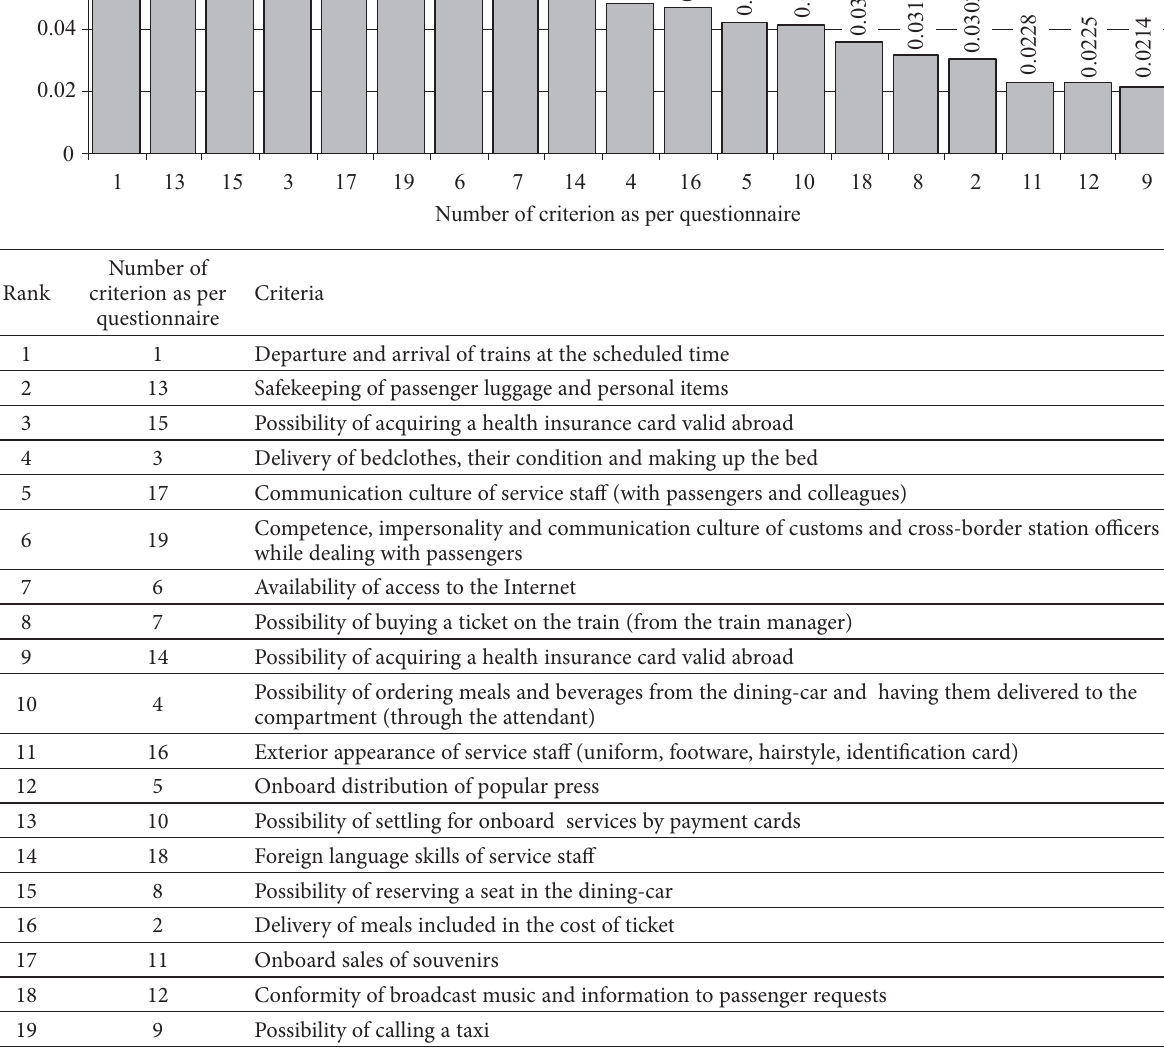
Fig. 4. Th e bar diagram showing the importance of criteria related to railway transportation process planning and technology determined based on respondents’